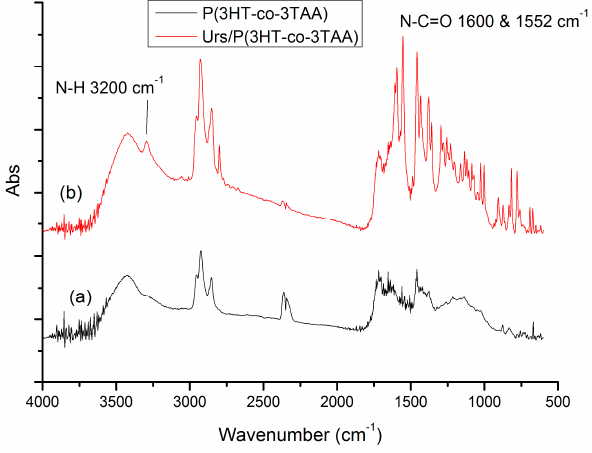
Figure 3. FT-IR spectra of ( a ) P(3HT- co -3TAA); ( b ) Urs/P(3HT- co -3TAA).